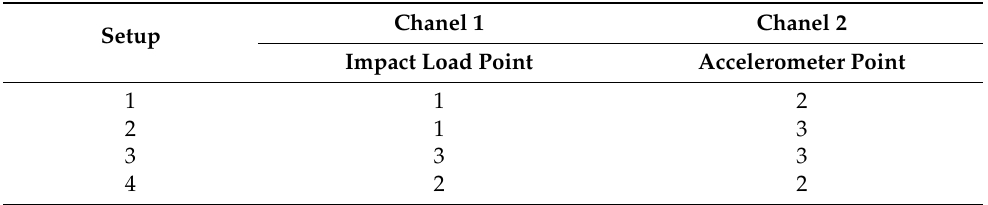
Figure 7. Modal identification test setups: ( a ) Setup 1, ( b ) setup 2, ( c ) setup 3, and ( d ) setup 4. Table 6. Measurement